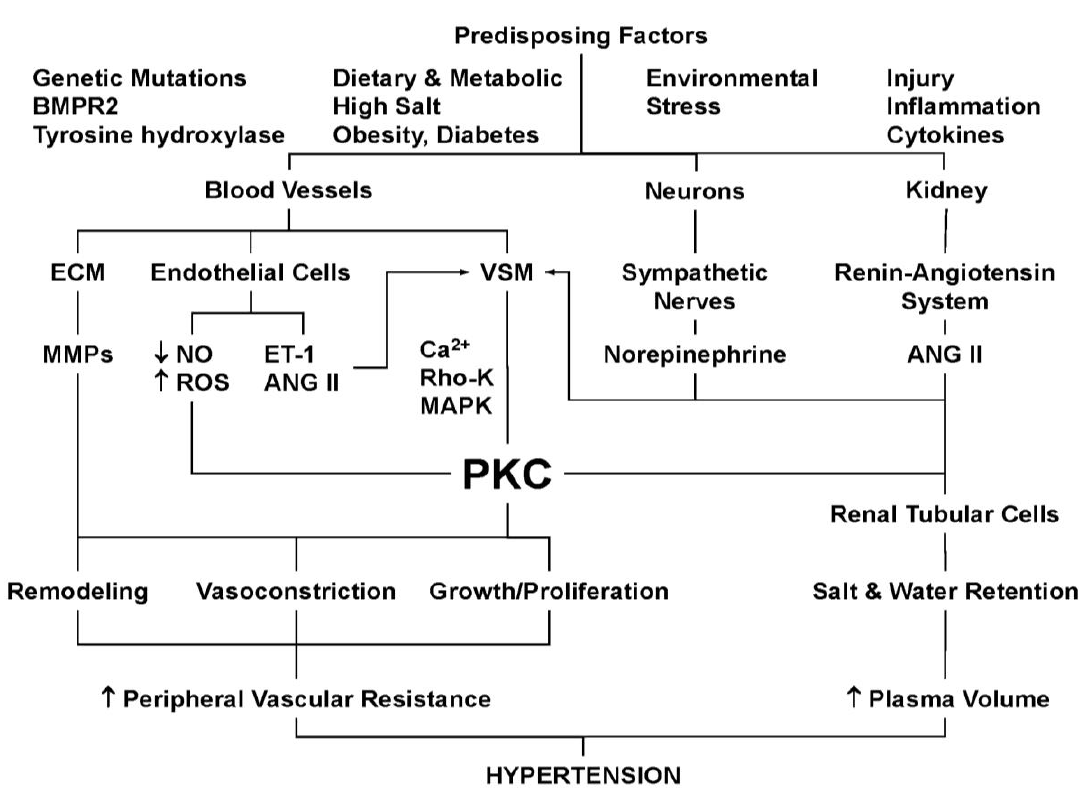
Figure 3. Role of PKC in hypertension. Genetic, dietary and environmental risk factors, lead to vascular, neural and renal dysfunction, and increased release of various mediators from endothelial cells (ROS, ET-1, ANG II), sympathetic neurons (norepinephrine) and the kidney (ANG II). These mediators could stimulate VSM and activate PKC, as well as Ca 2+ , Rho kinase, and MAPK thereby induce vasoconstriction and VSM growth and proliferation. The interaction of PKC with matrix metalloproteinases (MMPs) in the extracellular matrix (ECM) could contribute to vascular remodeling. Activation of the renin-angiotensin system (RAS) and increased ANG II production induce salt and water retention and increase plasma volume. Persistent increases in peripheral vascular resistance and plasma volume lead to